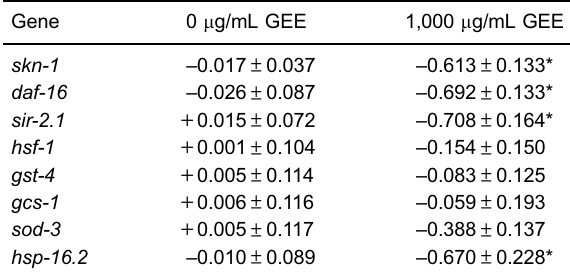
Table 2. Fold change mRNA expression of genes related to longevity and oxidative stress in wild-type 9-day-old adult worms treated with guarana ethanolic extract